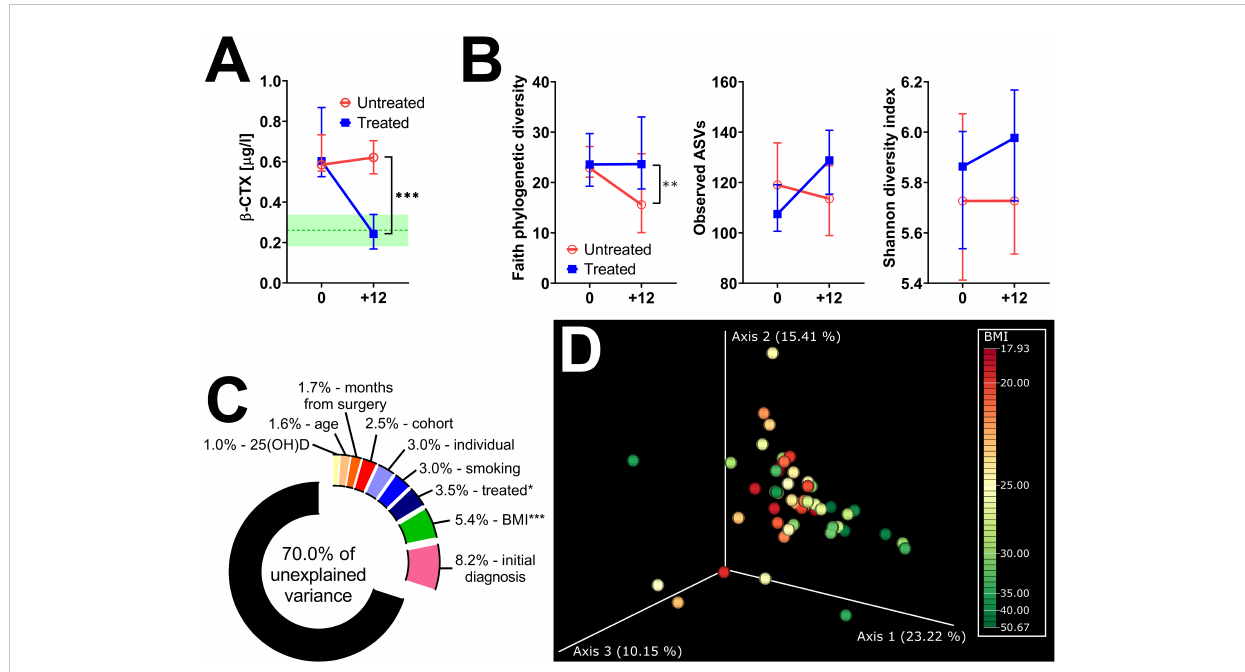
FIGURE 4 Twelve months of hormonal therapy normalized bone resorption and prevented the decrease in bacterial a -diversity. (A) Serum b -CTX in women after oophorectomy was normalized after 12 months of hormonal therapy ( n = 24) but remained high in untreated ( n = 27) women. Green line = median in women before surgery, green area = 95% CI. (B) Comparison of changes in a -diversity after 12 months of hormonal therapy or without it, as characterized by Faith ’ s phylogenetic diversity, observed features, or Shannon diversity index and analyzed by two-way ANOVA with Sidak ’ s multiple comparisons test. (C) Factors explaining microbiota variance analyzed by permutational multivariate analysis of variance using weighted UniFrac distance matrices at time 0. (D) Principal coordinate analysis (PCoA) plot using the weighted UniFrac distance metric shows a small shift in the fecal microbiota composition related to BMI. For a -diversity analyses, rarefaction was performed at 2,020 reads, and patients with lower yields in one time point were excluded from the analysis. *p < 0.05; ** p < 0.01; *** p <